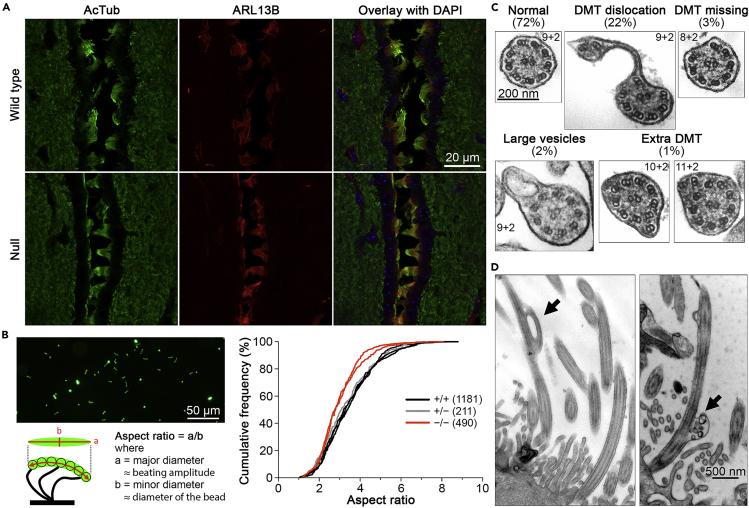
Motile Cilia Are Variably affected by the Hoatz−/− Mutation(A) Confocal microscopy of the third ventricle of wild-type and Hoatz−/− mice. These coronal brain sections were incubated with antibodies against acetylated α-tubulin (green) and ARL13B (red). The nuclei were detected using DAPI (blue). Note the collapsed and straight mutant cilia. Scale bar, 20 μm.(B) Measurement of the ciliary beating amplitude of primary cultured ependyma. Top left: representative image. The movement of motile cilia was visualized using fluorescent microbeads (exposure time, 50 ms). The major and minor axes of the best-fitting ellipse to the trace were calculated using ImageJ. Bottom left: The beating amplitude was estimated as the value of the aspect ratio (major diameter)/(minor diameter) assuming that the minor axis represents the diameter of the microbead. Right: Cumulative frequency plot of the aspect ratios of wild-type (n = 1,181), heterozygotes (n = 211), and null mutants (n = 490). p < 0.001, Hoatz−/− versus wild-type.(C) Representative horizontal sections of ependymal cilia observed in Hoatz−/− mice. The cilia (n = 216) were classified into five groups. DMT, doublet microtubules.(D) Representative longitudinal sections of the motile cilia of the ependyma of a Hoatz−/− mutant mouse showing a dislocated axonemal microtubule or an abnormal vesicle-containing small particle (black arrows).See also Figure S3.